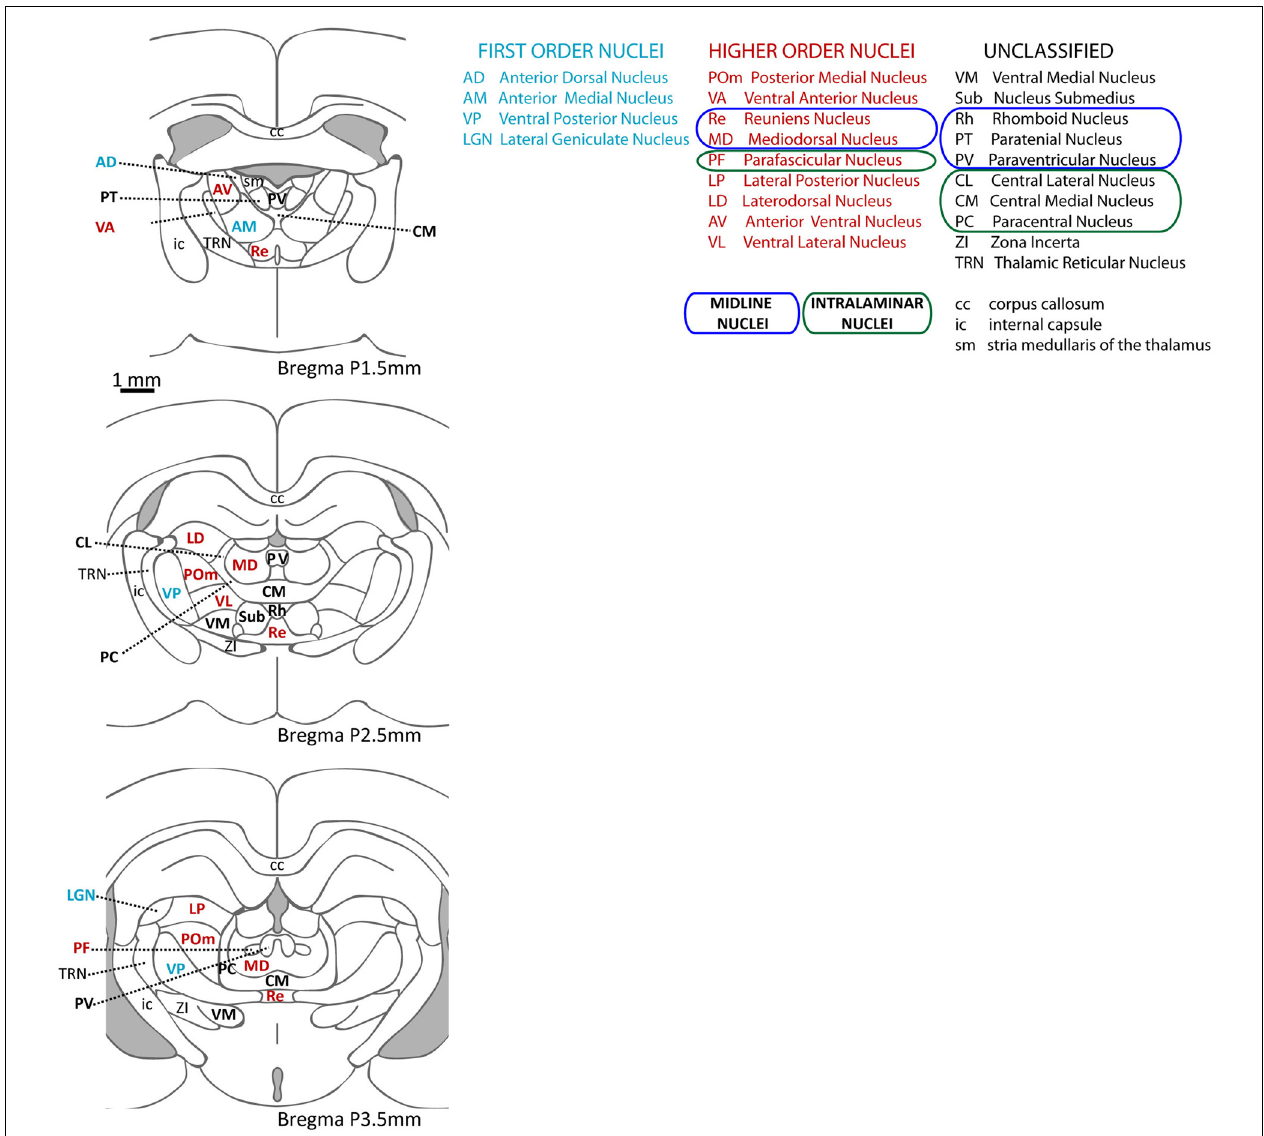
FIGURE 2 |Thalamic nuclei in the rat. Schematic representation of the nuclei in the rat thalamus at three different anteroposterior levels (based on Paxinos and Watson, 2004) and their abbreviated names. First order nuclei are labeled in blue, higher order in red, and nuclei that have not been